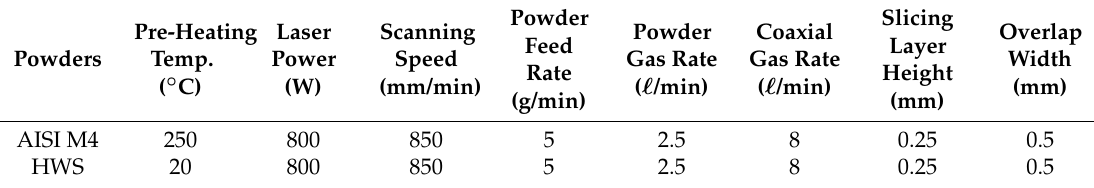
Table 2. Processing parameters